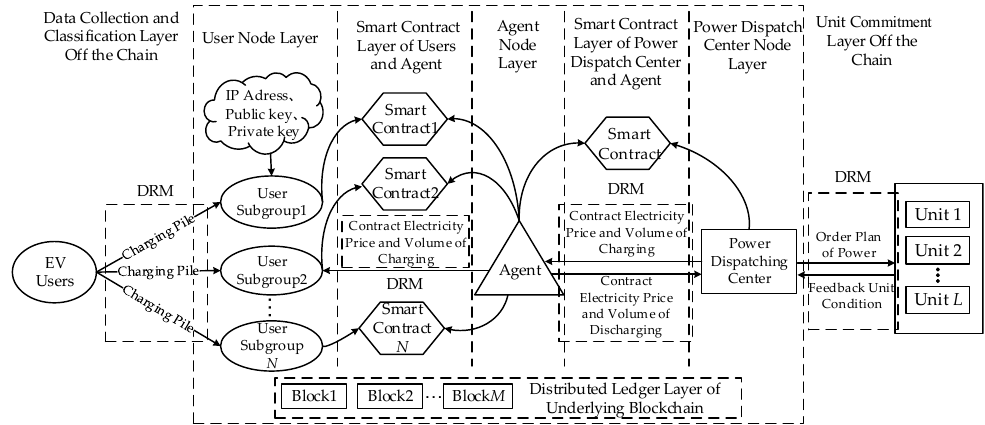
Figure 1. Bidding transaction framework for electric vehicles (EVs) under smart contract.